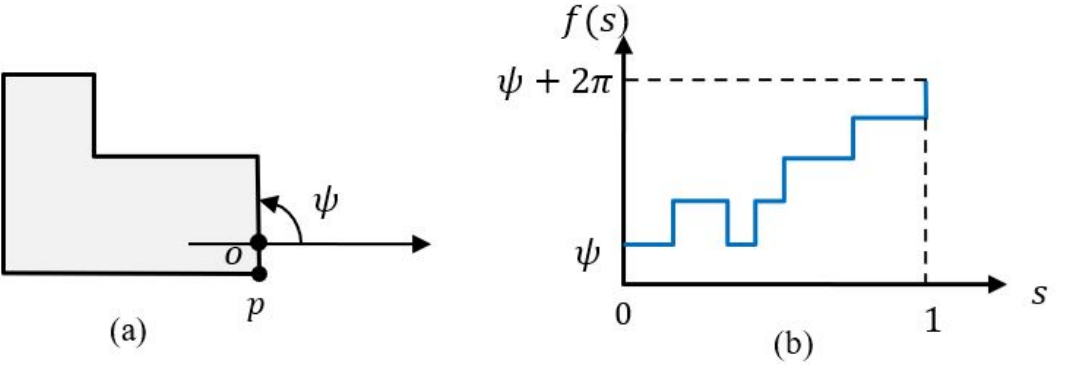
Figure 12. Definition of the turning function: ( a ) shows the tangent angle ψ , and ( b ) presents the turning function.